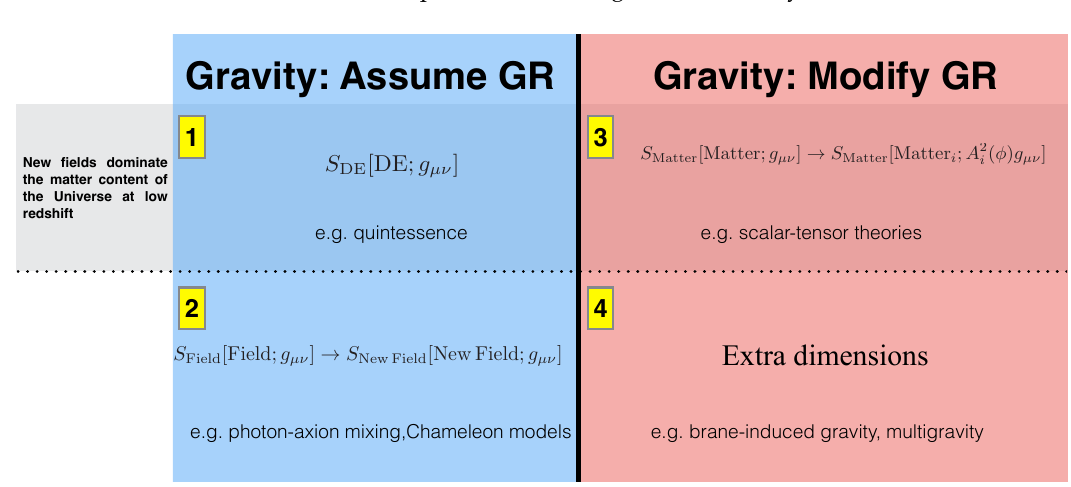
Figure 7. The four main classes of dark energy theories, within the two broad strategies, classified as modifications of the General Relativistic action. Classes 1 and 2 assume the gravitational metric coupling of GR, whereas classes 3 and 4 modify this metric coupling, and are therefore modifications of gravity. In the upper line of classes (1 and 3), new fields dominate the matter content of the recent universe. Adapted from